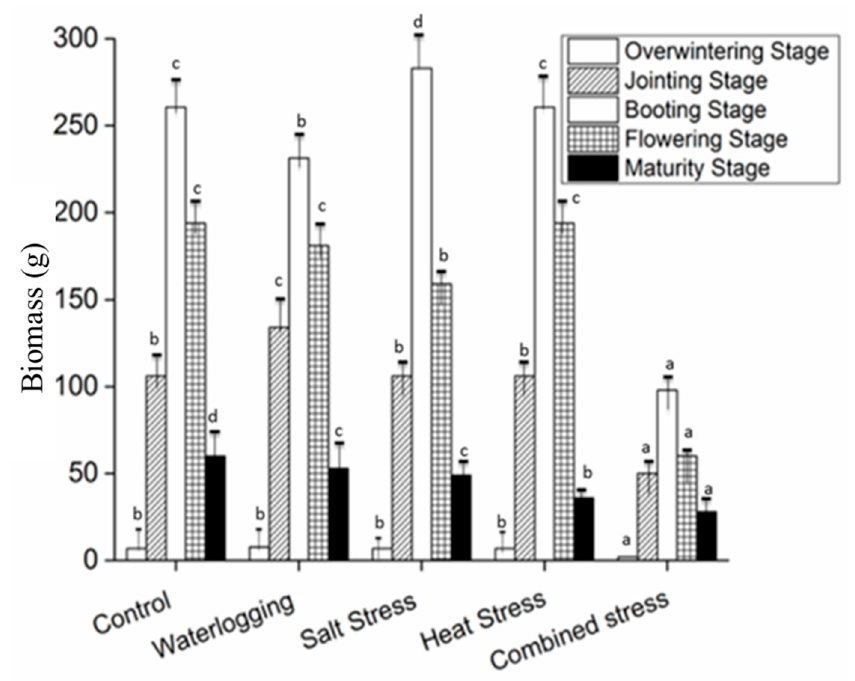
Figure 5. Fresh biomass of wheat plants during five-stage growth of plants grown under different abiotic stresses. Reported values are the means and standard deviations of triplicates for each treatment. Note: sampling date at overwintering stage was 28 December 2020; at jointing stage was 12 March 2021; at booting stage was 30 Mar 2021; at the flowering stage was 17 April 2021; and at maturity stage was 28 May 2021. Lowercase letters show the significant differences within treatments according to one-way ANOVA and DMRT, while the significance level was p ≤ 0.05.